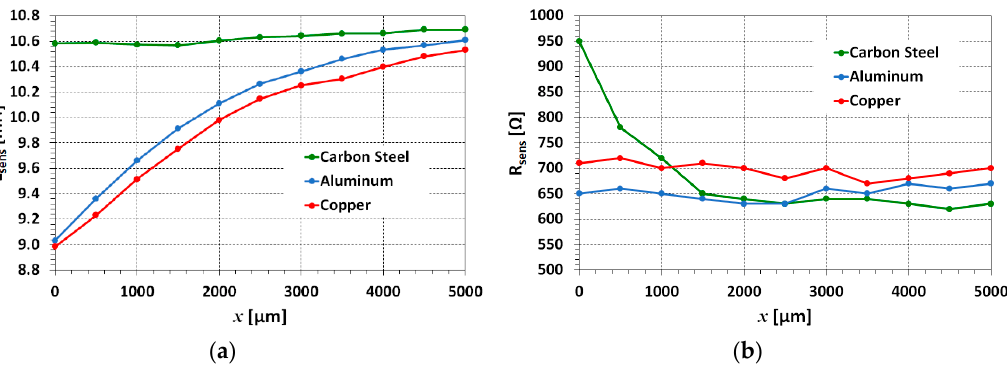
Figure 5. Inductance L sens ( a ) and resistance R sens ( b ) of the whole sensing system comprising a sensing coil and target over the displacement, x , for each of the three considered 1 mm thick targets. The data were extracted from the S 11 measurements carried out by means of the E5071C Network Analyzer connected to the terminals of the sensing coil that was previously disconnected from the ECI.